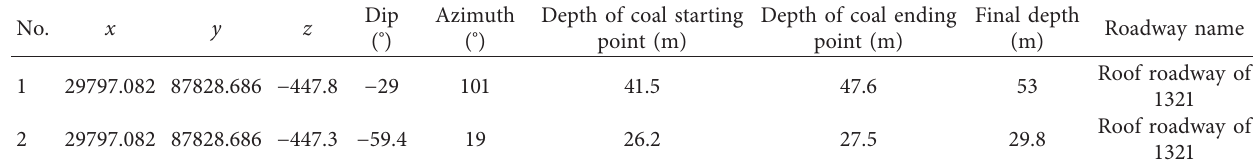
Table 1: Original data table of underground geological drilling results.